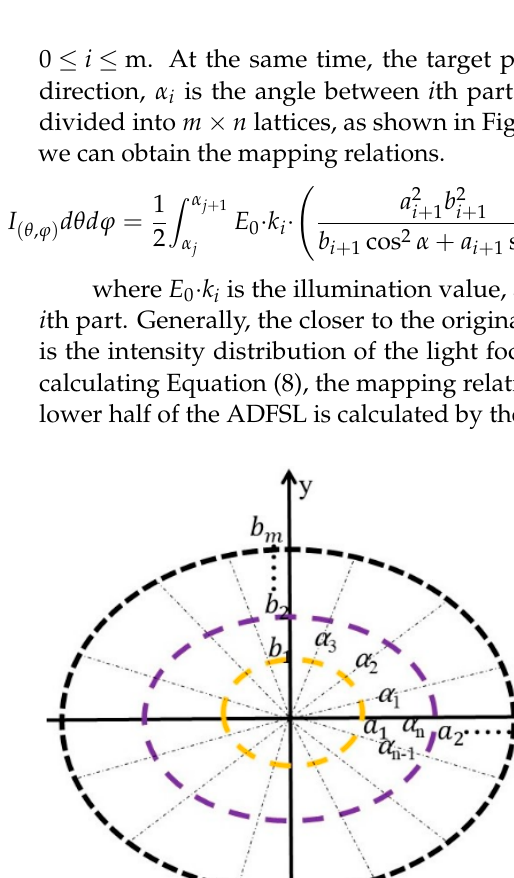
( b ) Figure 9. ( a ) Integrated headlamp based on ellipsoidal reflector and ( b ) sketch of the freeform reflector. Due to the symmetry of the reflector, only half of the freeform surface reflector was designed. An initial point is given and the normal vector of the initial point can be ob- tained according to the vector form of the reflection law, which can be expressed as out